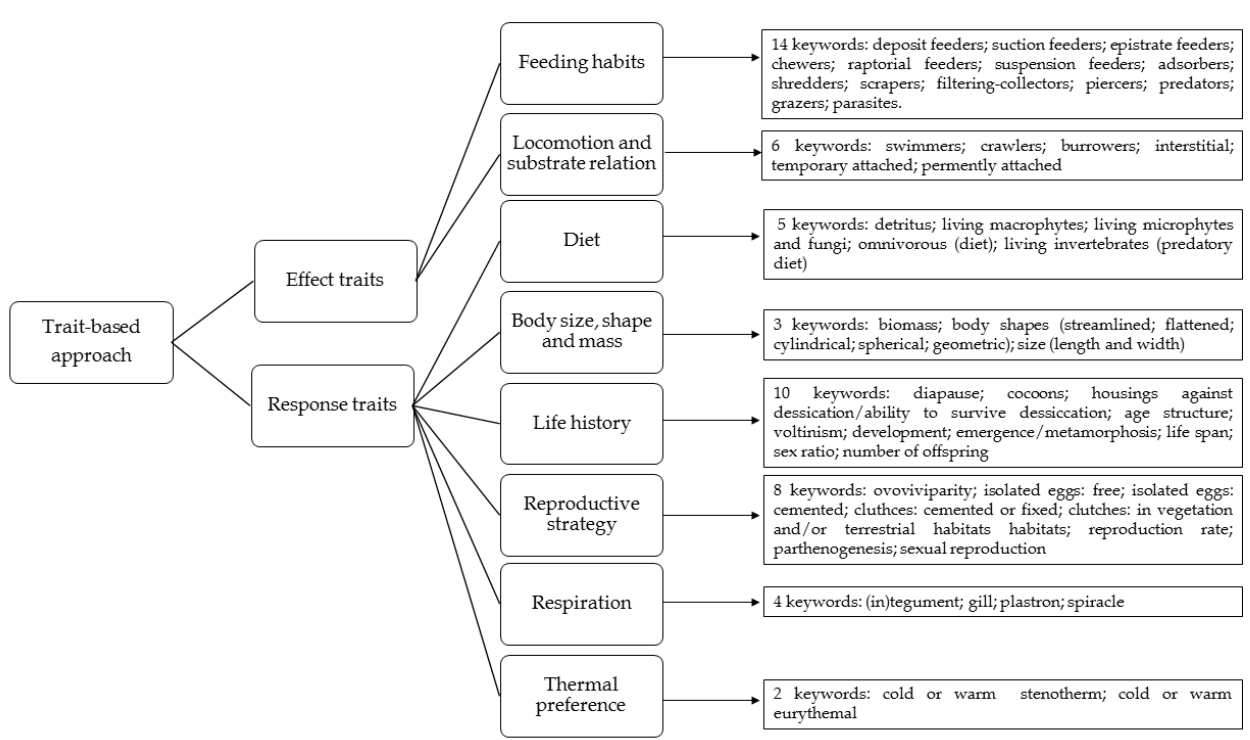
Figure 1. Flow chart of the methodological processes. The ovals indicate the initial phases, the rec- tangles represent the processes (the main process is in bold) and the cylinders indicate the databases.